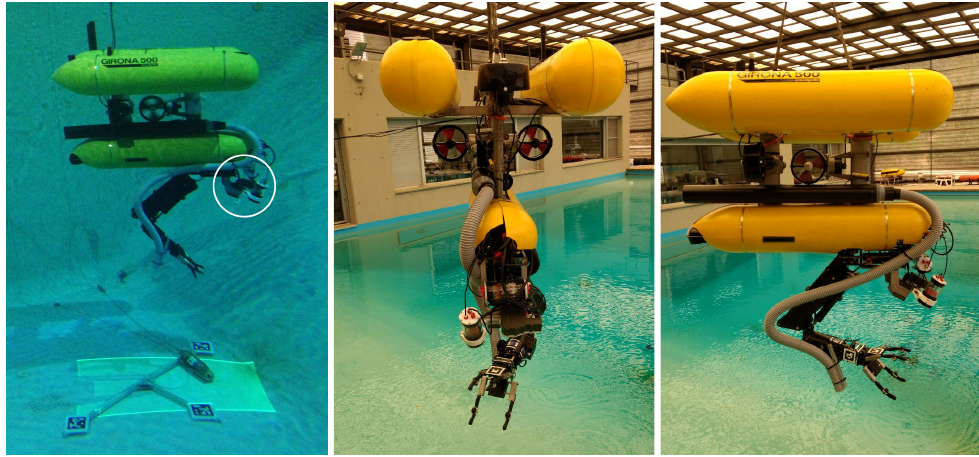
Figure 5. Girona 500 AUV with the four DoF robotic arm and the laser scanner. On the left, the robot is scanning an amphora, and the scanner is highlighted with a white circle. On the centre and on the right, the robot is ready for